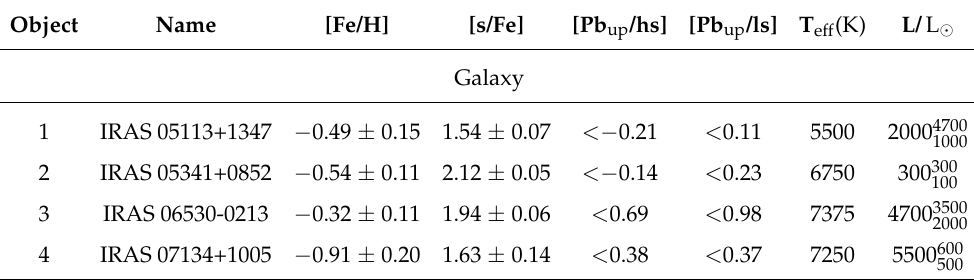
Table A1. Abundance ratios ([s/Fe], [Pb up /hs], [Pb up /ls]) and metallicities of the s -process rich single stars considered in this study, together with their effective temperature, and photospheric luminosities. See text for more